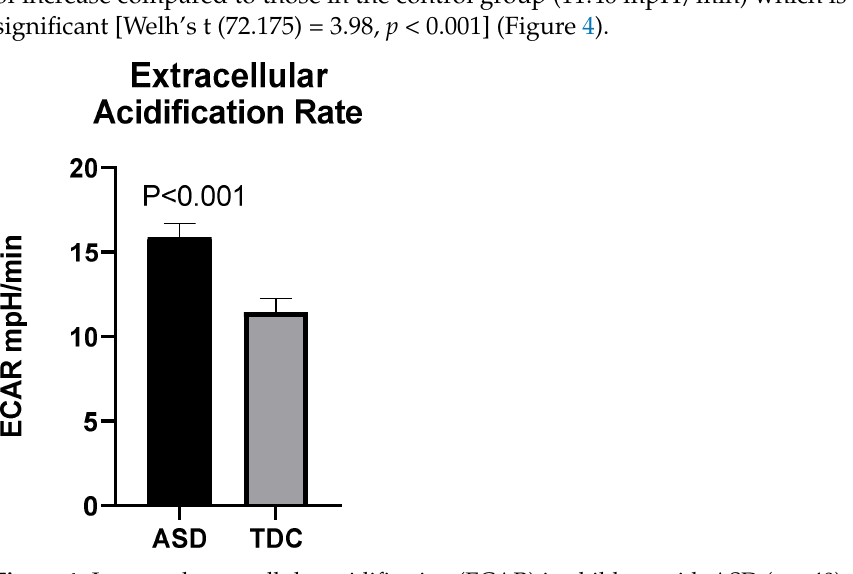
Figure 4. Increased extracellular acidification (ECAR) in children with ASD ( n = 40) compared to TDC ( n = 12).